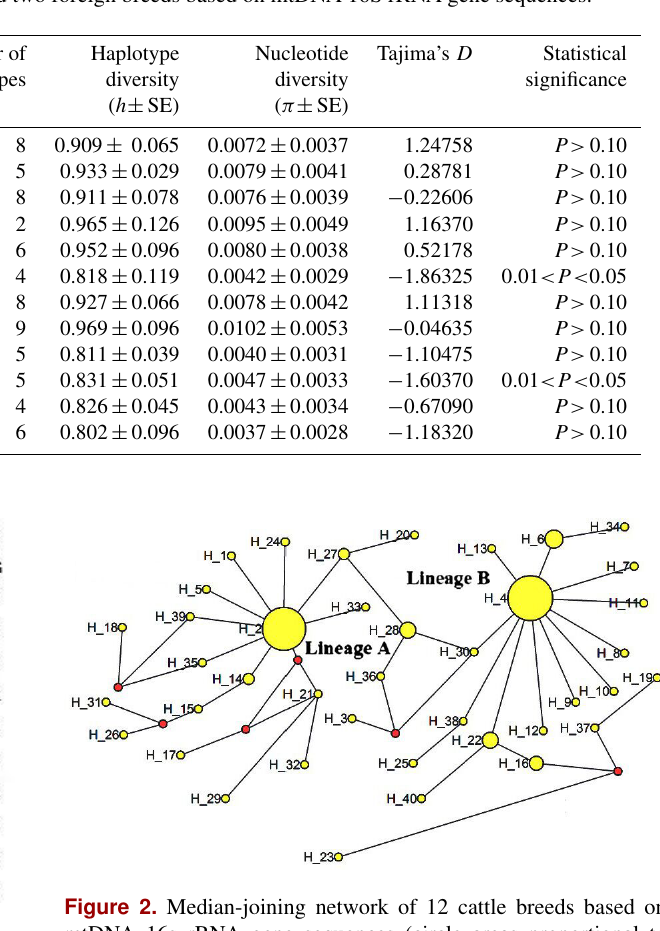
Figure 1. UPGMA dendrogram for 12 cattle breeds based on ge- netic distances between mtDNA 16S rRNA gene sequences com- puted using the Kimura two-parameter model. Abbreviations given in Table 1. Japanese Black ( Bos taurus ) and Angus ( Bos taurus ) were control breeds.